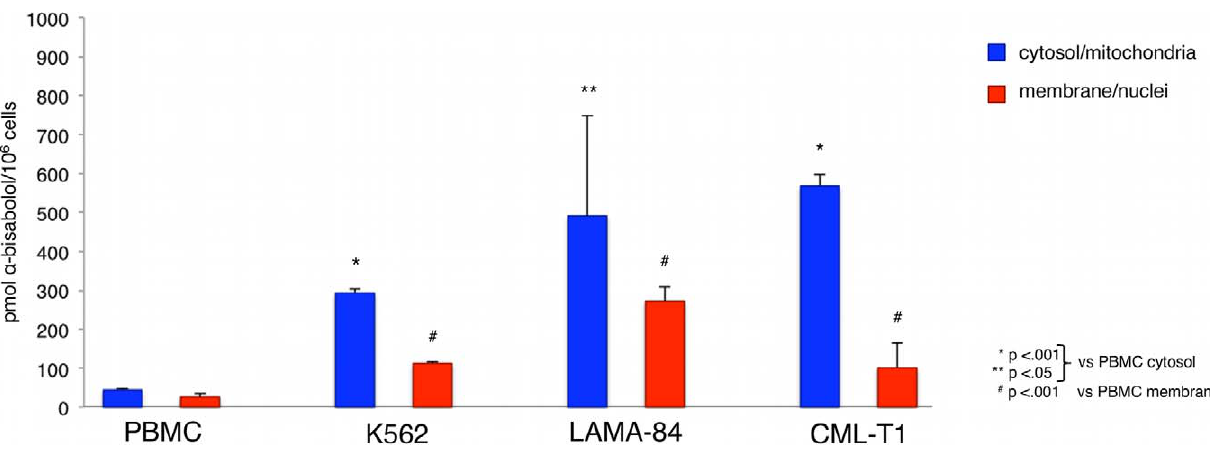
Figure 4. a -bisabolol concentrations in cellular compartments of BCR-ABL + vs normal cells. Cell lines were treated with 40 m M a -bisabolol for 24 hours. a -bisabolol concentrations were significantly higher both in cytosol and membrane/nuclei compartments of BCR-ABL + vs normal cells. The results are expressed as mean 6 SD of 3 experiments for each cell line.